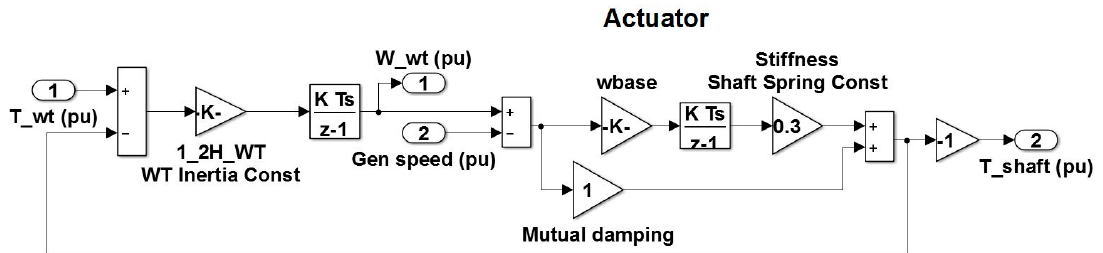
Figure 3 . Governor control of a wind turbine. Figure 3. Governor control of a wind